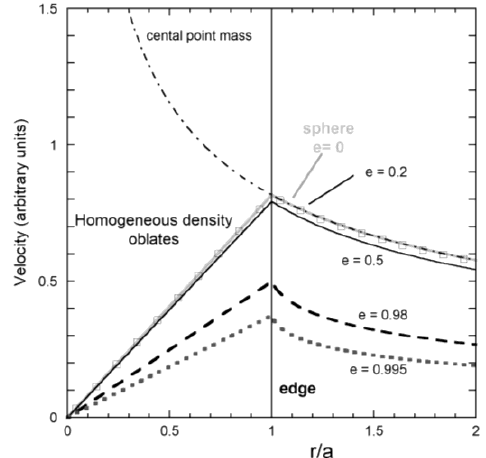
Figure 8. Forward models of rotation curves for a test particle orbits, comparing a large, central point mass (dot-dashed curve) to orbits both in and around oblate bodies with homogeneous density but varying ellipticity (various black curves). Gray curve = a sphere, for which e = 0: this same pattern was obtained for Coulombic forces in and around a sphere with uniformly distributed charge (e.g., figure 28–9 in [49]). The dashed curve represents an axial ratio of c / a = 0.2, whereas the dotted curve depicts c / a = 0.1. For variable density, the maximum would be rounded rather than a corner, and thus would resemble the idealized RC curves in Figure 7b. Please note that this approach assumes orbiting points or rings, not co-rotating spheroidal shells.